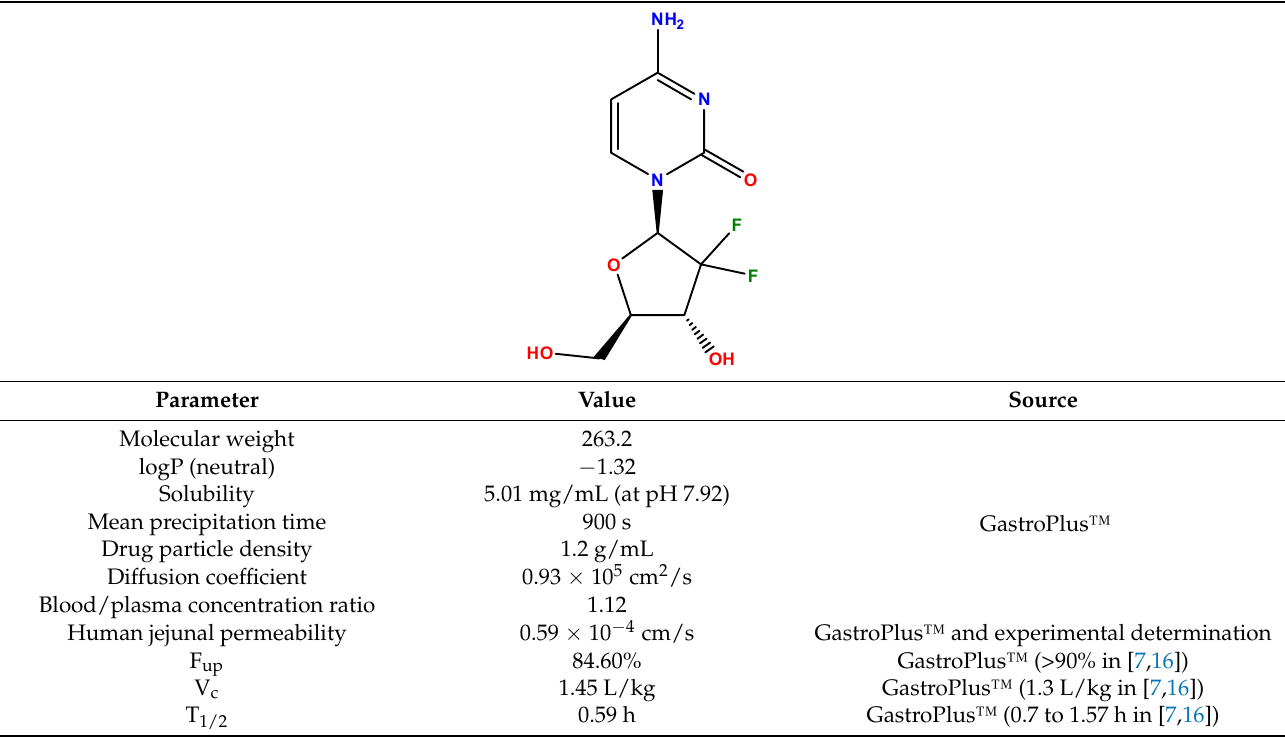
Table 1. Structure, parameters and gemcitabine properties predicted by GastroPlus™ used in the simulations.